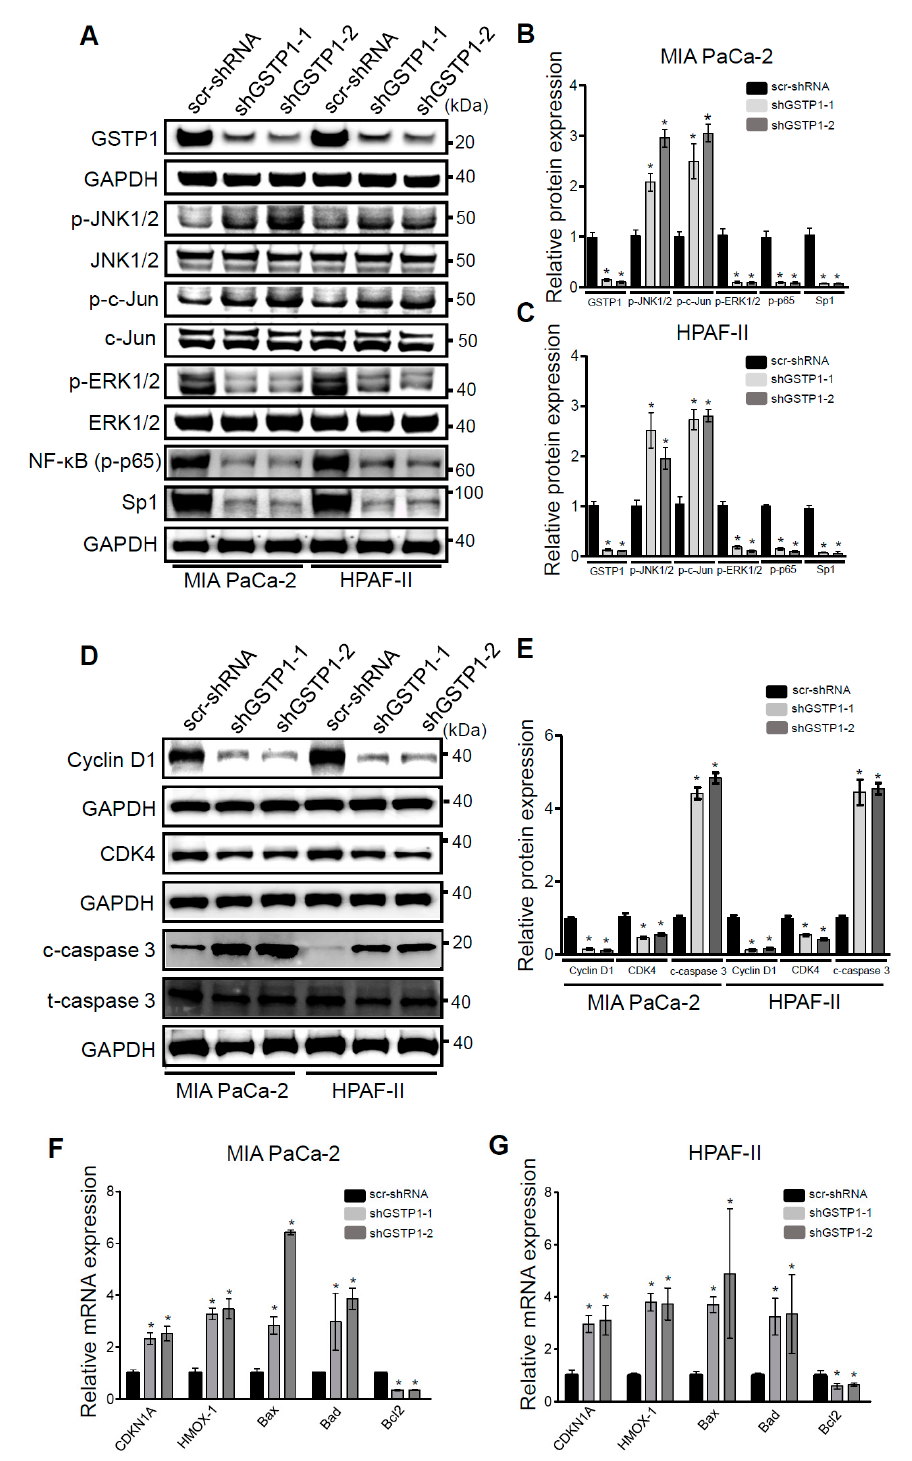
Figure 4. GSTP1 knockdown activates oxidative stress-mediated apoptotic and survival pathways in PDAC cells. ( A ) Phosphorylated (p-) levels of JNK1 / 2, c-Jun, extracellular signal-regulated kinase (ERK), and p65 and total specificity protein 1 (Sp1) protein expression were measured in GSTP1 knockdown PDAC cells via Western blotting. Levels of total JNK / 2, c-Jun, and ERK1 / 2 were determined to confirm that changes in phosphorylated proteins were not due to changes in total protein level and to normalize the phosphorylated protein levels. GAPDH was used as a loading control. Changes in protein expression were quantified using densitometry for control and GSTP1 knockdown ( B ) MIA PaCa-2 and ( C ) HPAF-II cells. The protein levels were compared between shGSTP1-1 or shGSTP1-2 and scr-shRNA groups. The graphs show the ratio of phosphorylated proteins to total proteins in the knockdown groups relative to the scr-shRNA control. The figures show representative images for three independent experiments. ( D ) Protein levels of cyclin D1, CDK4 and activation (cleavage) of caspase-3 was analyzed in GSTP1 knockdown PDAC cells using immunoblotting. GAPDH and total caspase-3 were used as loading controls. ( E ) Cyclin D1, CDK4, and cleaved caspase-3 protein expression was quantified using densitometry. The figures show representative images for three independent experiments. The protein levels were compared between shGSTP1-1 or shGSTP1-2 and scr-shRNA groups. ( F , G ) Relative mRNA levels of CDKN1A , HMOX- 1 , Bax , Bad , and Bcl2 were quantified using qRT-PCR in control (scr-shRNA) and GSTP1 knockdown (shGSTP1-1 and shGSTP1-2) for MIA PaCa-2 and HPAF-II cells. Student’s t -test was used to identify significant differences for the above experiments. Statistically significant changes in expression levels in GSTP1 knockdown groups compared to the control are shown with * ( p < 0.05). Unprocessed images for the Western blotting results are shown in Figure S1. 2.6. Addition of Glutathione Reverses the Effects of GSTP1 Knockdown on Cell Viability and Oxidative Stress-Response Signaling We next evaluated the ability of an exogenous antioxidant, glutathione (GSH), to reverse the cytotoxic effects of GSTP1 knockdown in PDAC cells. Control and GSTP1 knockdown MIA PaCa-2 and HPAF-II cells were treated with 5 mM GSH for 72 h. Our results show that GSH treatment attenuated the effects of GSTP1 knockdown in PDAC cells. The growth inhibitory effects of GSTP1 knockdown were significantly diminished upon GSH treatment (Figure 5A), suggesting that the accumulation of endogenous ROS is a leading cause of reduced cell survival in GSTP1 knockdown cells. We not only see the reduced expression of p-JNK in GSH-supplemented GSTP1 knockdown cells, but also the protein expression of Sp1 was found to be restored (Figures 5B and C). Overall, these results indicate that the loss of GSTP1 function surges ROS levels, activates JNK, and suppresses Sp1, which leads to changes in gene expression associated with oxidative stress, cell proliferation, survival, and cell death (Figure 5D).